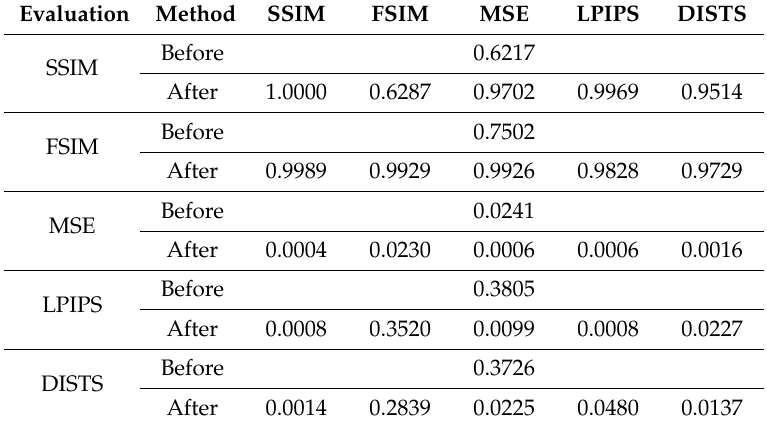
Table 3. Statistical analysis on the effect of IQA on the results of image restoration. Unlike SSIM and FSIM, smaller values mean better results in MSE, LPIPS and DISTS.